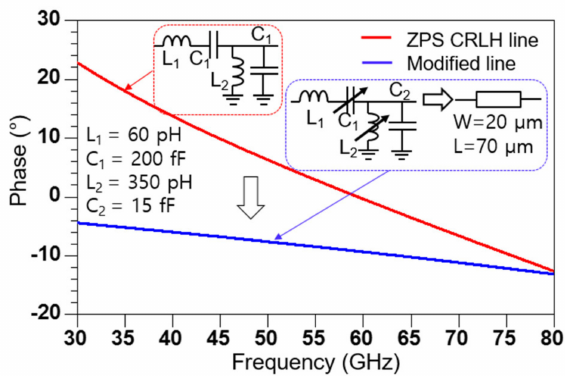
Figure 5. Phase characteristics of the ZPS composite right- / left-handed (CRLH) line and modified